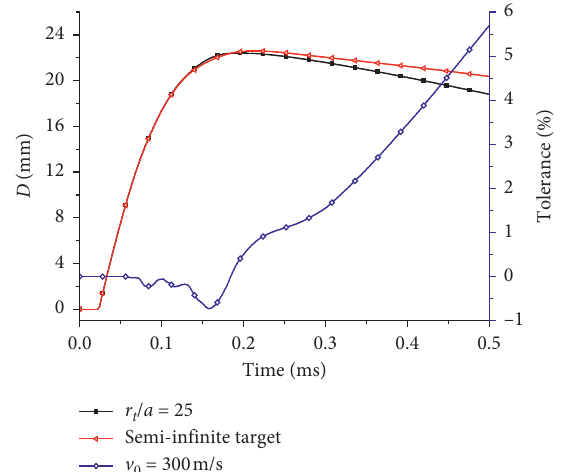
Figure 19: Deviation comparison of the penetration depth for the free boundary ( r t / a � 25) and the nonreflecting boundary ( v � 300m/s).